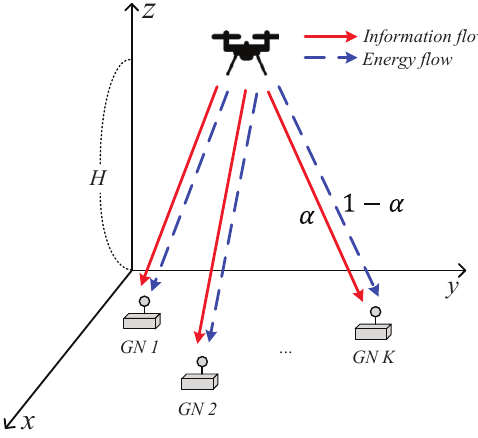
Figure 1. Model of a UAV-assisted SWIPT